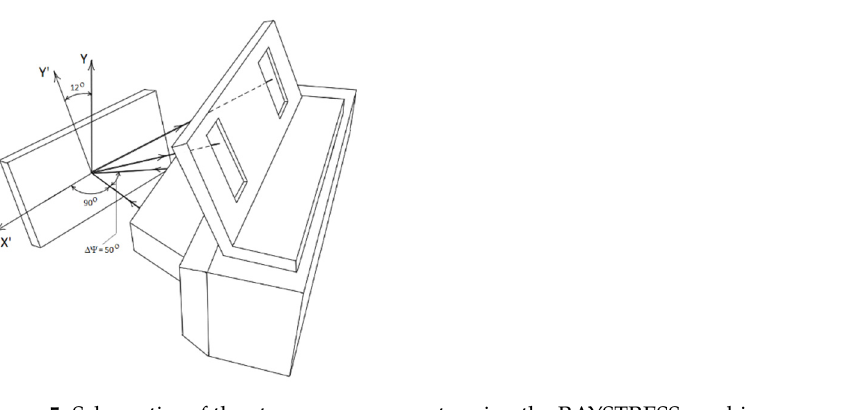
Figure 5. Schematics of the stress measurements using the RAYSTRESS machine.